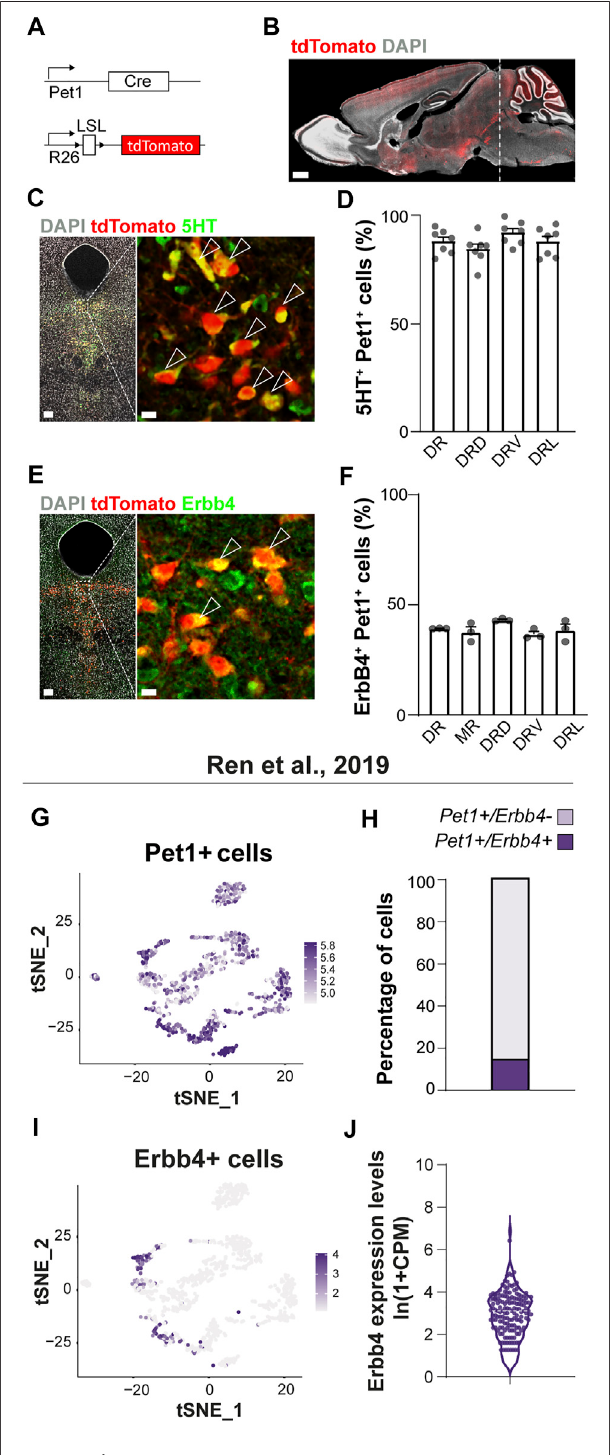
FIGURE 1 | Erbb4 expression in serotonergic neurons of the dorsal raphe labelled in Pet1 -reporter mice. (A) Genetic strategy to generate Pet1 - reporter mice. LSL: loxP-STOP-loxP. (B) Sagittal brain section of an adult Pet1 -reporter mouse showing tdTomato-labelled projections and 5HT neurons located in the raphe nuclei (dashed line). (C) Confocal images of 5HT immunohistochemistry and Pet1 -tdTomato+ neurons in the dorsal raphe